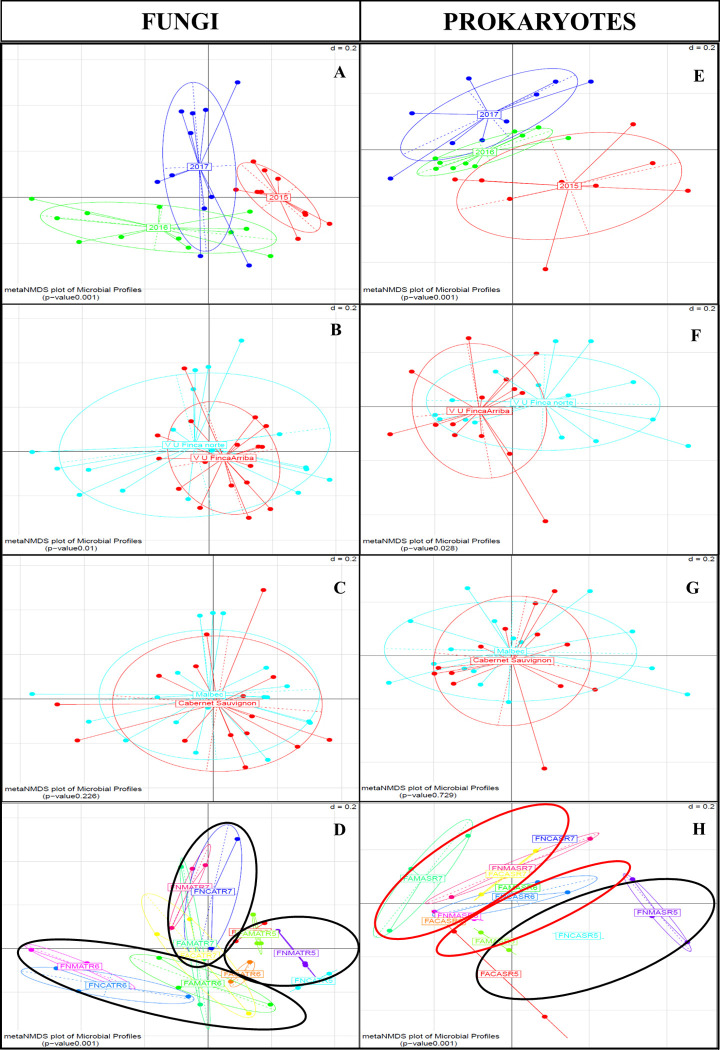
Non-metric Multidimensional Scaling (NMDS) of microbial communities by vintage, location, cultivar and plots.(A) Fungal communities grouped according to the vintage, (B) location, (C) cultivar and (D) plot. (E) Prokaryotic communities grouped according to the vintage, (F) location, (G) cultivar and (D) plot. Samples were grouped at 20% of dissimilarity distance using the generalized Unifrac metric. P values to observe significant difference between communities were obtained through a PERMANOVA test, and are represented on the left hand corner of each figure.